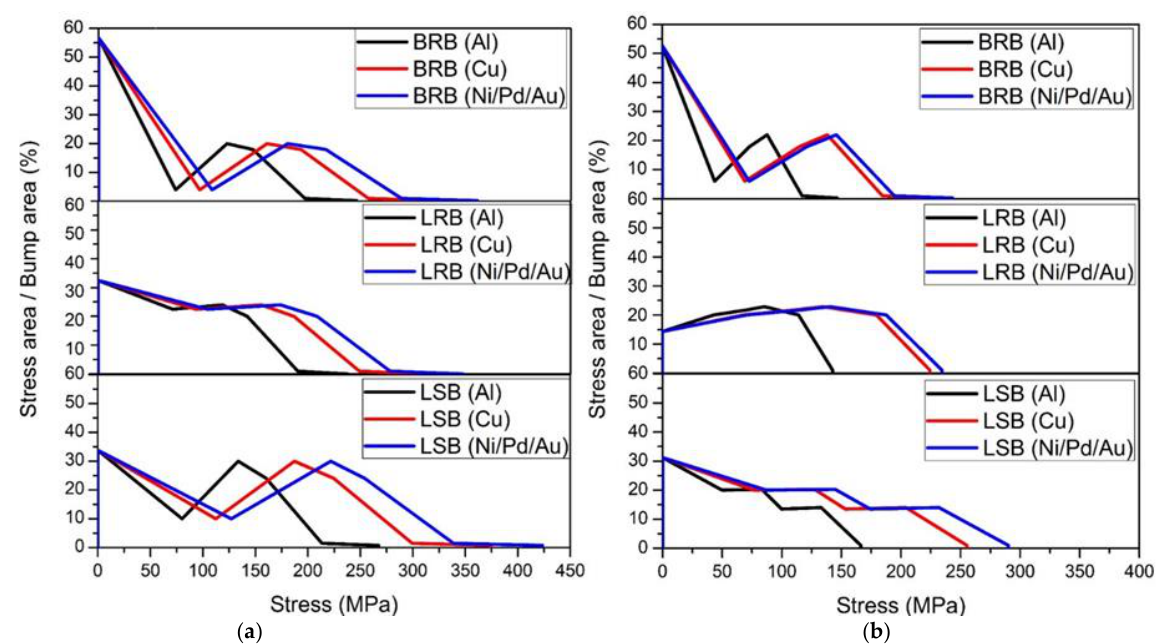
Figure 9. Quantitative simulated stress distribution on bonding surface and corresponding area fraction: ( a ) 10 μm bumps and ( b ) 5 μm bumps.